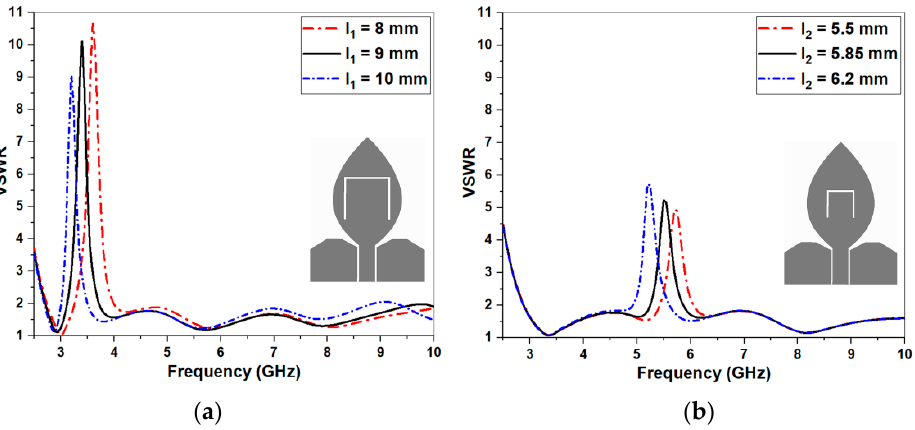
( b ) Figure 2. Simulated current distribution on the proposed antenna surface: ( a ) 3.5 GHz; ( b ) 5.5 GHz.